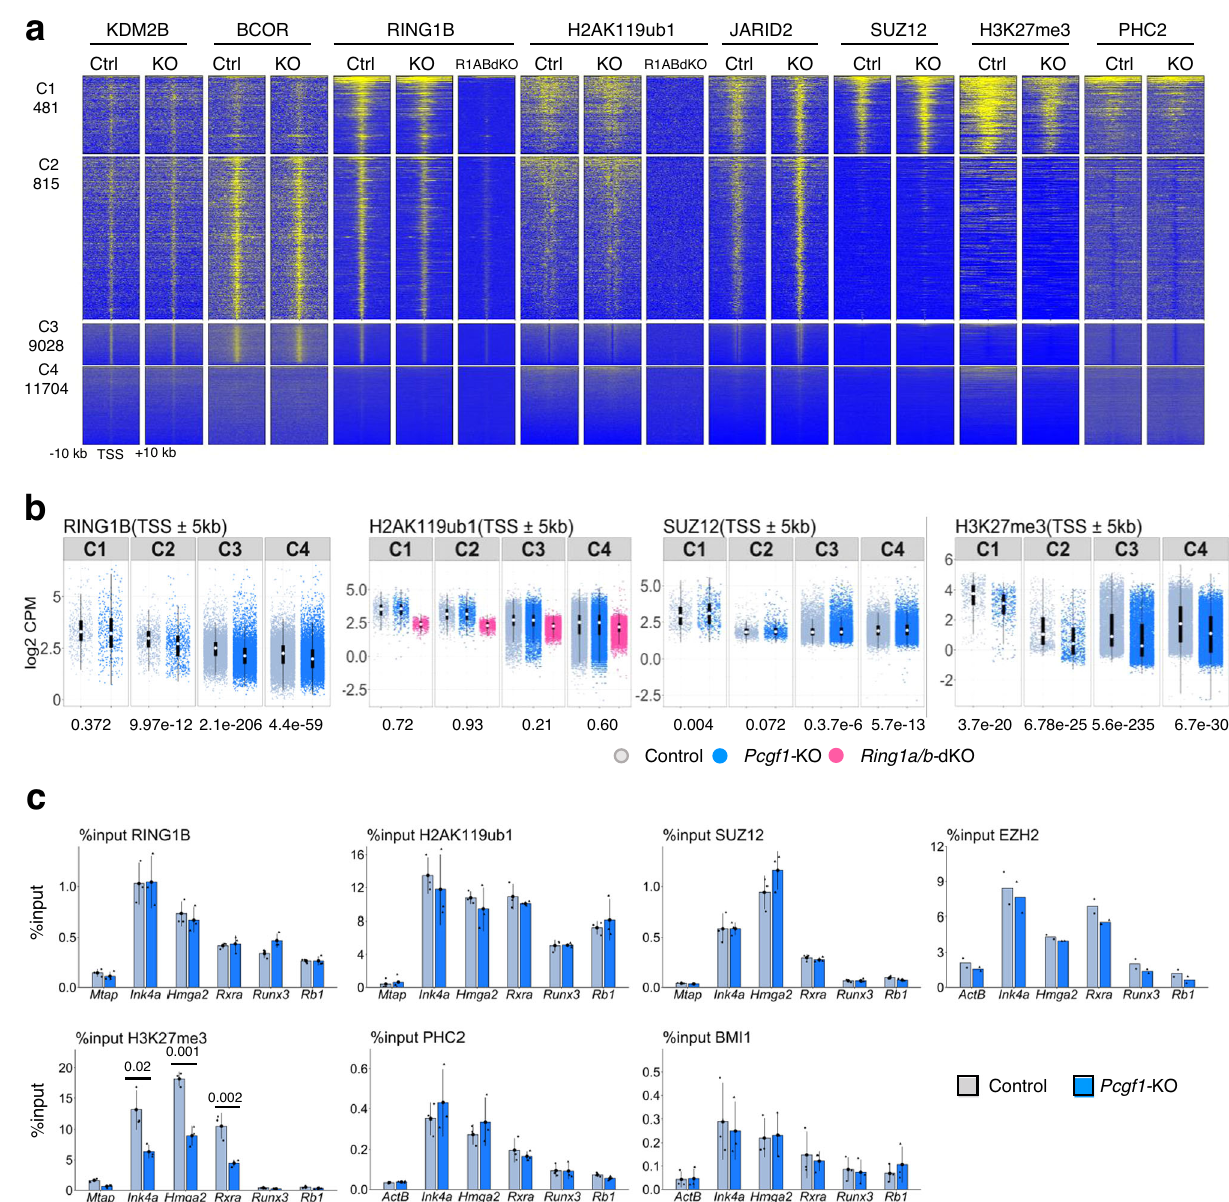
Fig. 3 | PCGF1 is involved in stabilizing H3K27me3 at TSS regions without impactontheenrichmentofH2AK119ub1andSUZ12intargetgenesofIdHPCs. a Target binding of KDM2B, BCOR, RING1B, H2AK119ub1, JARID2, SUZ12, H3K27me3 and PHC2 in control (Ctrl) and Pcgf1 -KO (KO) IdHPCs. A heatmap of ChIP-seq signals across TSS(±10kb) of C1, C2, C3, and C4 genes in control and Pcgf1 -KO is shown. Local levels of RING1B and H2AK119ub1 were also tested in Ring1a/b -dKO (R1ABdKO) IdHPCs as controls. H3K27me3 ChIP-seq were calibrated by spike-in chromatin. Representative data of biological duplicates are shown except for RING1B ChIP-seq in Ring1a/b- dKO IdHPCs, which was obtained from a single experiment. b Box plot views for ChIP-seq results across TSS (±5kb) for RING1B,H2AK119ub1,SUZ12andH3K27me3ineachclusterincontrol, Pcgf1 -KOand